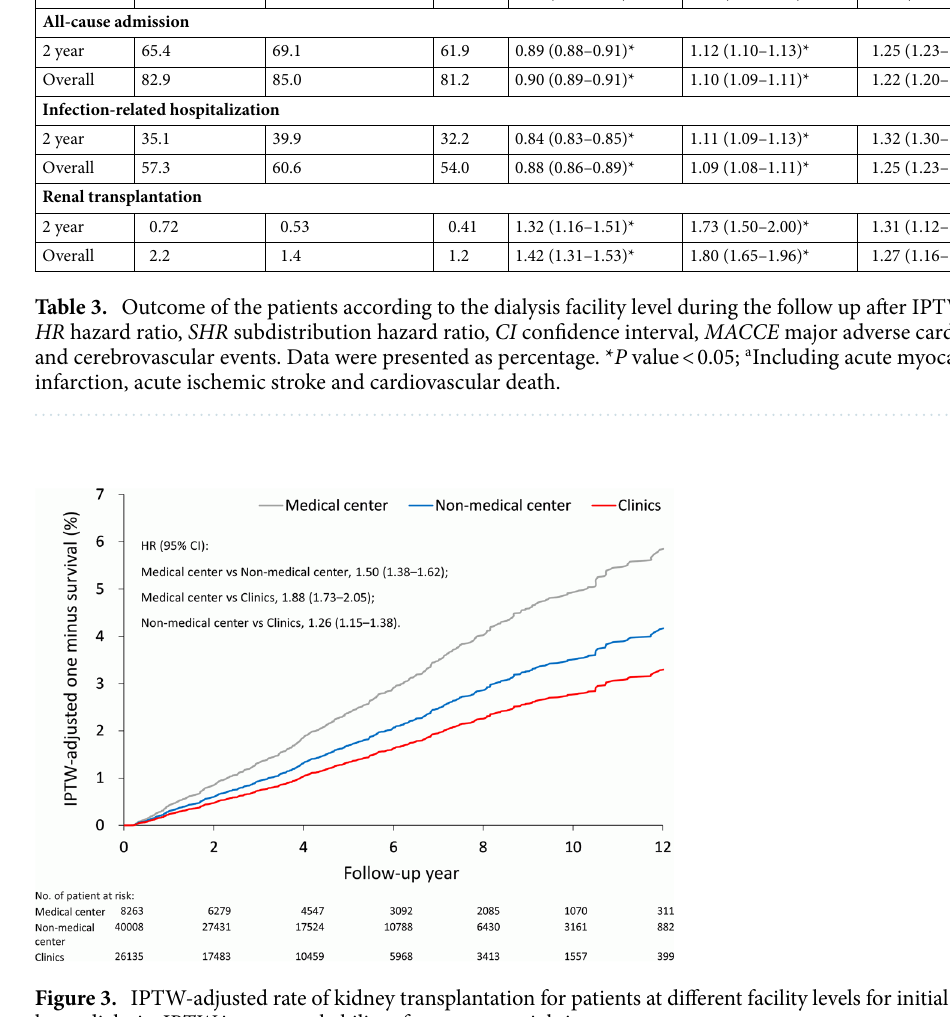
Figure 3. IPTW-adjusted rate of kidney transplantation for patients at different facility levels for initial hemodialysis. IPTW inverse probability of treatment